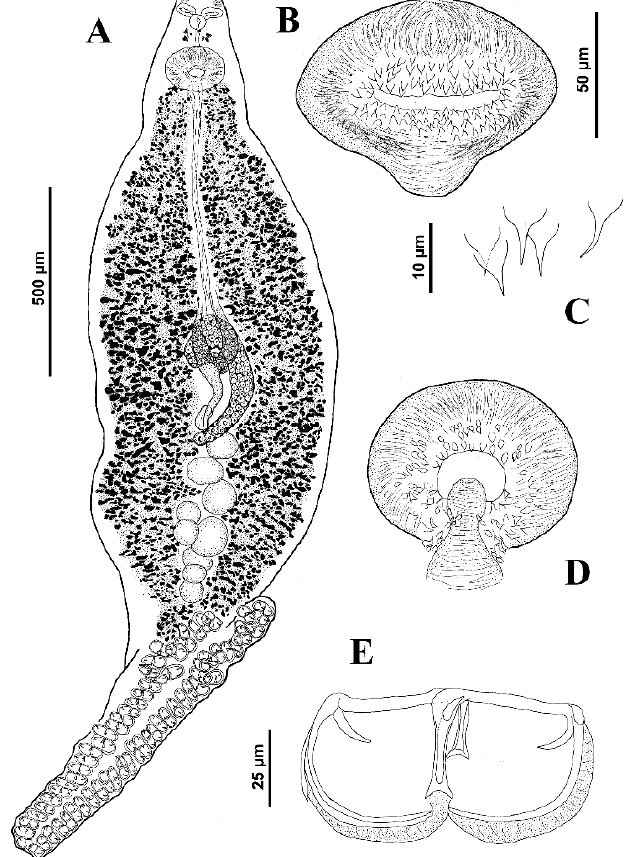
Figure 10. Microcotyle multilineatus n. sp. from the Brown chromis, Chromis multilineata . ( A ) Whole mount (composite, ventral view) ( B ) Genital atrium ( C ) Spines ( D ) Deeper focus of the genital atrium ( E ) Clamp.